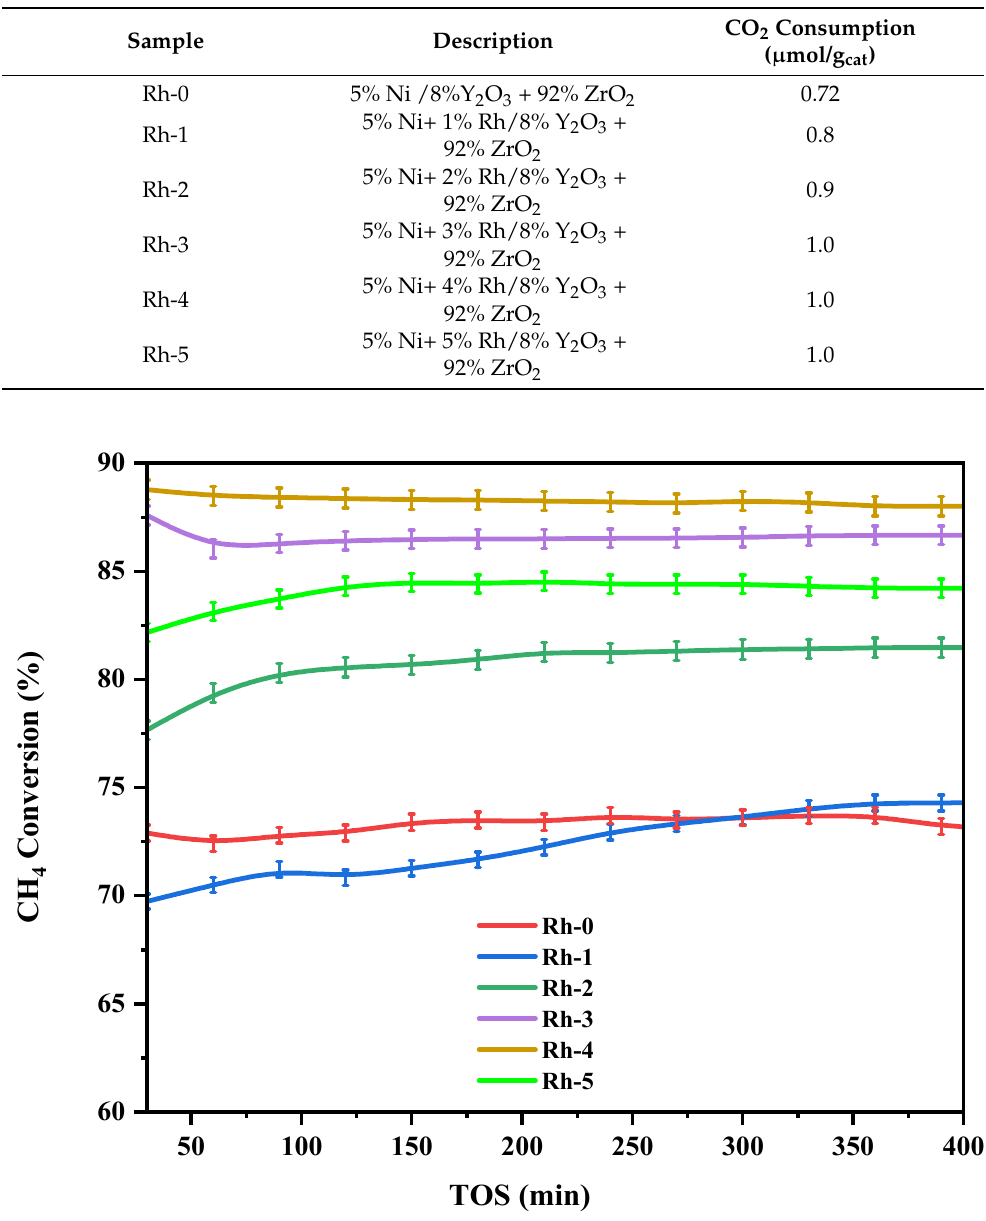
Figure 5. CH 4 conversion versus TOS for the Ni-Rh-x (x = 0, 1, 2, 3, 4, 5 wt.%) catalysts operated at 800 °C.